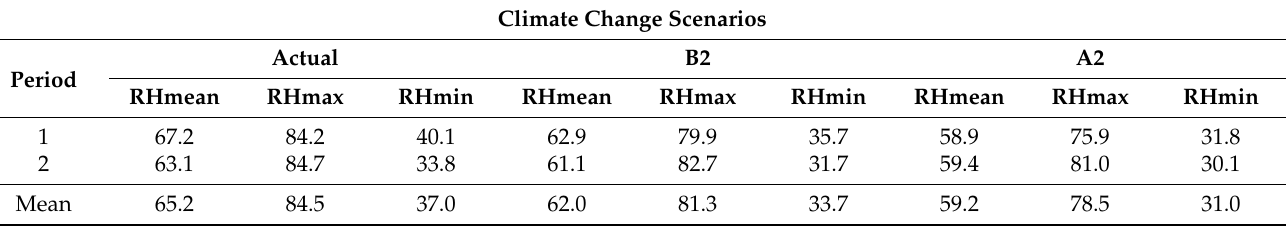
Table 2. Relative humidity values (%) in Mossor ó , Rio Grande do Norte state, Brazil, during the melon cultivation period (cultivars Honeydew and Galia), using the PRECIS climatological model, considering the Intergovernmental Panel on Climate Change’s emission scenarios.